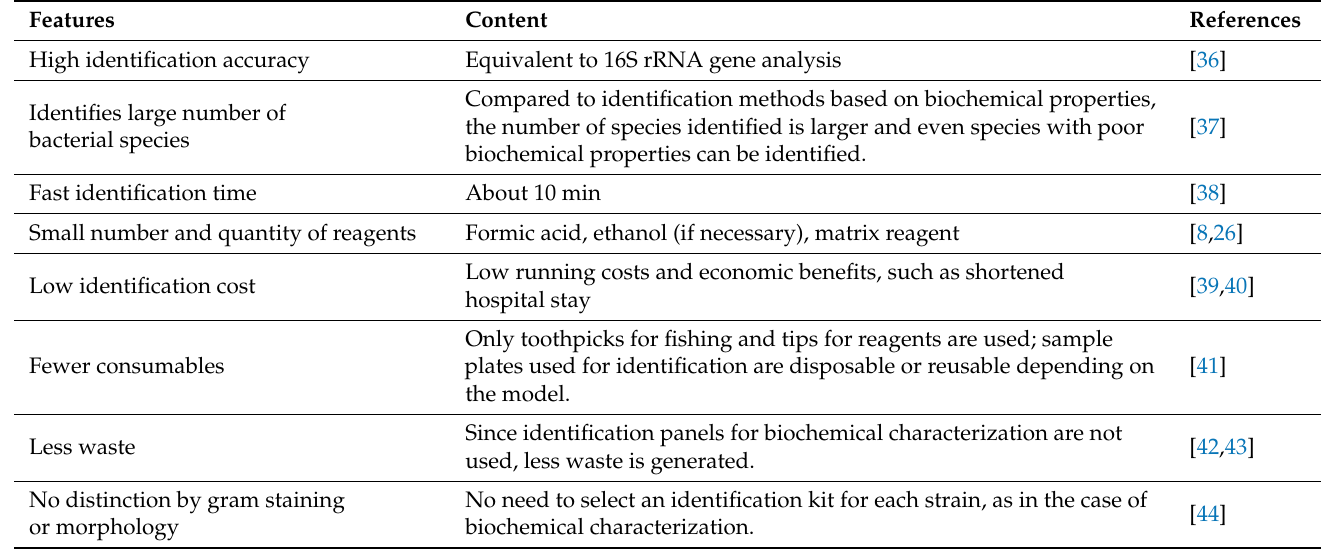
Table 1. Features and advantages of microbial identification by mass